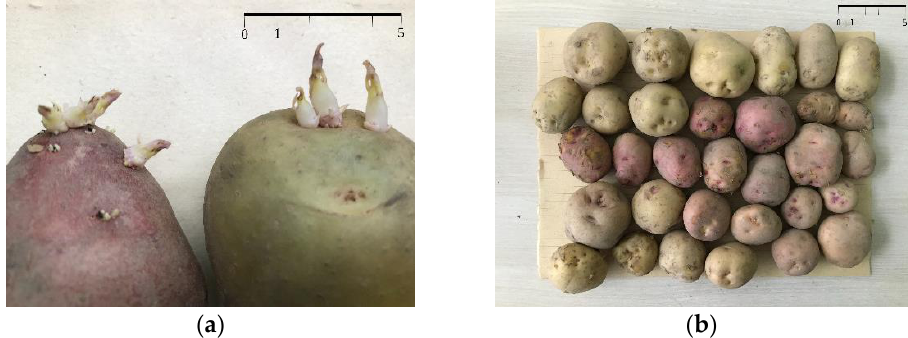
Figure 1. ( a ) Tubers of parental genotypes cv. Sudarynya (right) and 13/11-09 clone (left); ( b ) tubers of F1 segregants Tubers of cv. Sudarynya (right) and of the 13/11-09 clone (left).